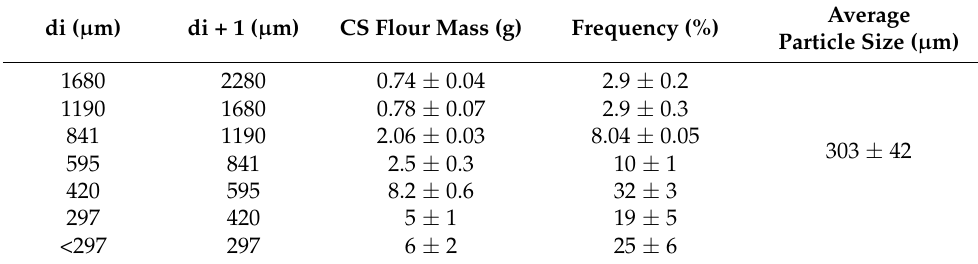
Table 1. Particle size distribution of CS